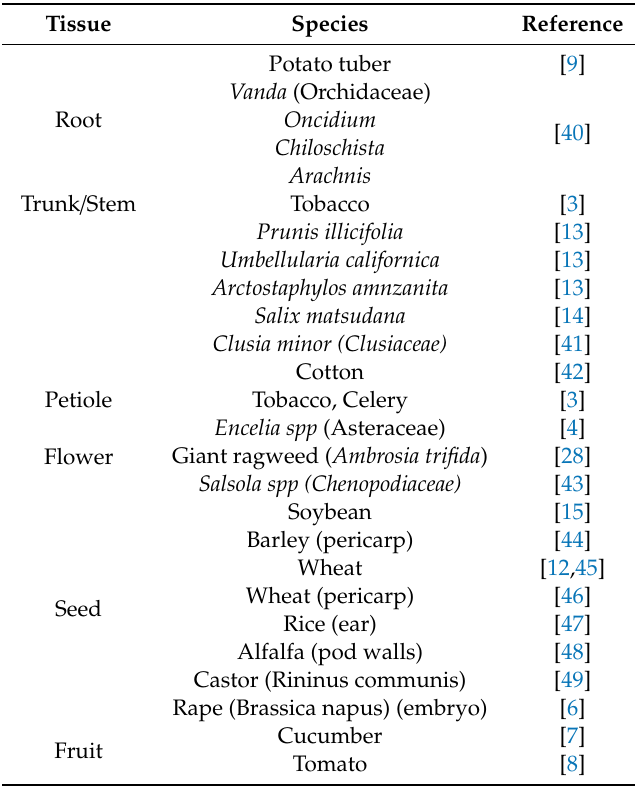
Table 1. Studies of non-leaf photosynthesis in